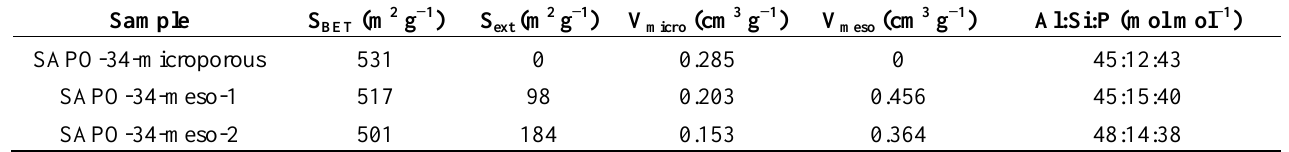
Table 1. Structure data and composition of the SAPO-34 samples under study